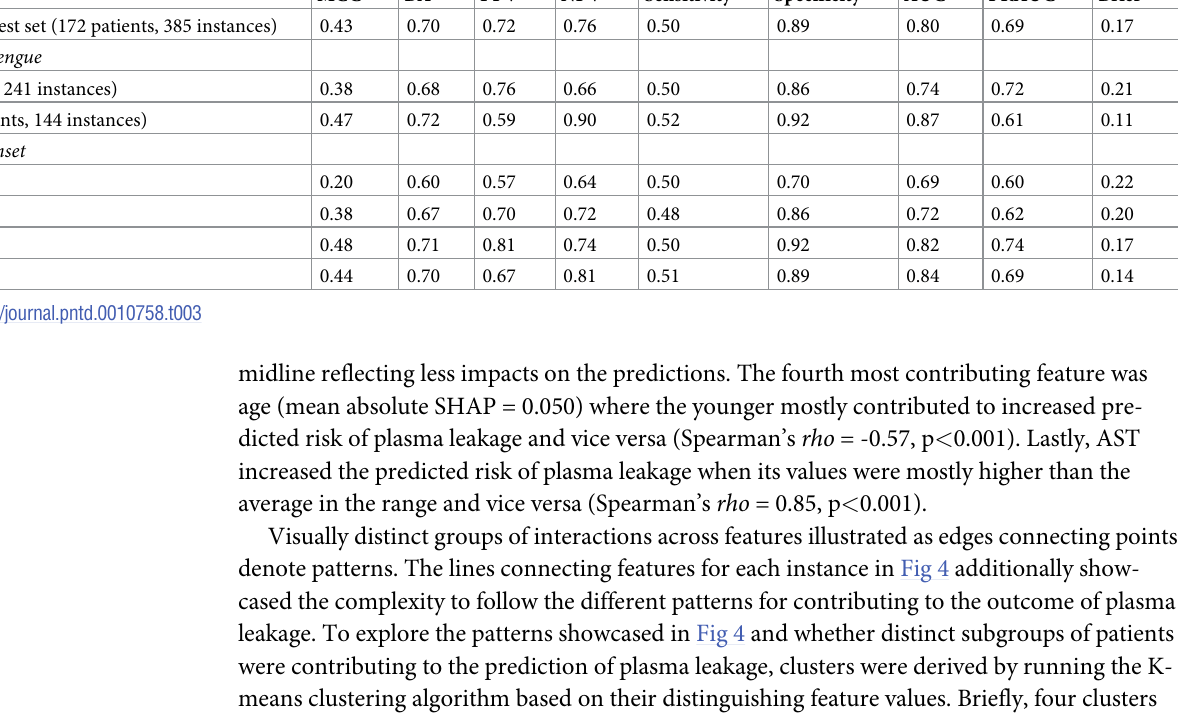
Table 3. Prediction performance of the final model to predict plasma leakage on test set. Model (DENV 5F-AS ) Performance on the test set (172 patients, 385 instances)